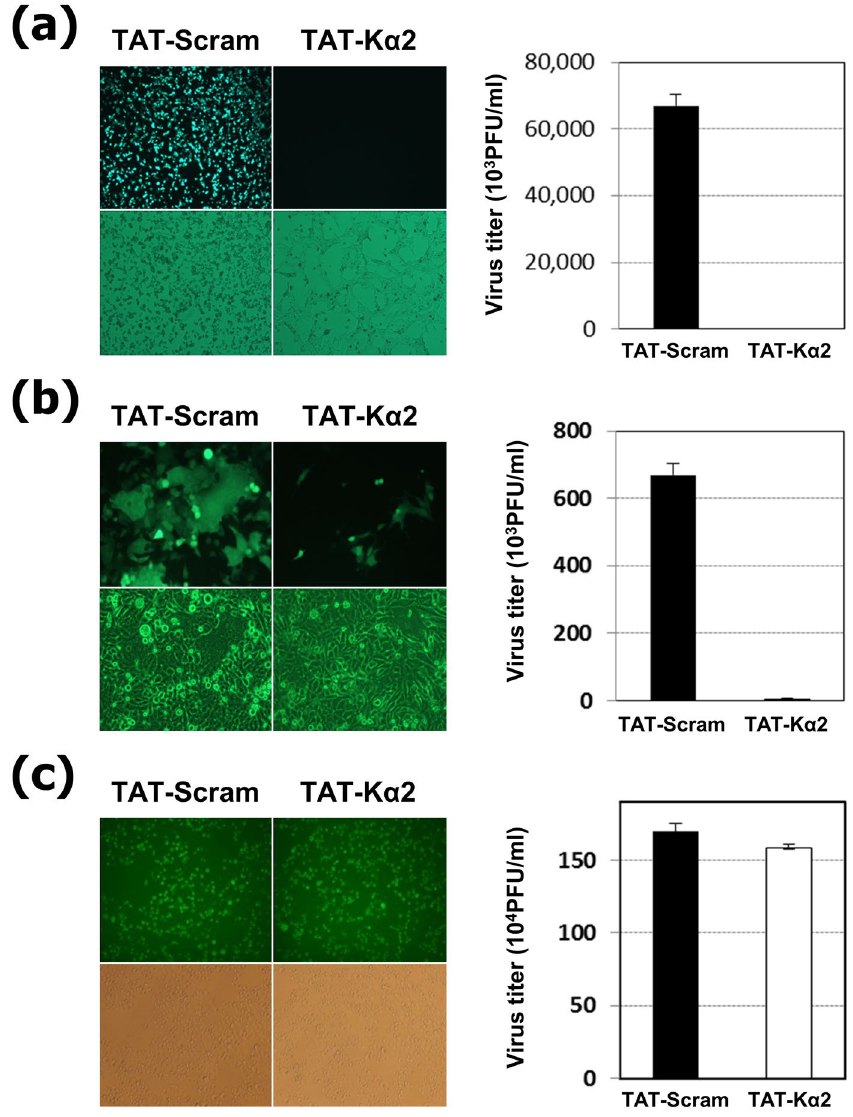
Figure 4. Broad-spectrum activity of the TAT-K α 2 peptide and its specificity. Enveloped viruses, ( a ) VSV (293T cells) and ( b ) RSV (Hep2 cells), and a non-enveloped virus, ( c ) Coxsackievirus (HeLa cells), were tested to determine the antiviral effects of TAT-K α 2 peptide against other viruses. The 40 μ M of TAT-K α 2 peptide or TAT-scramble peptide was pre-incubated with the respective viruses, cell infection was determined by GFP expression, and the titers of each virus were